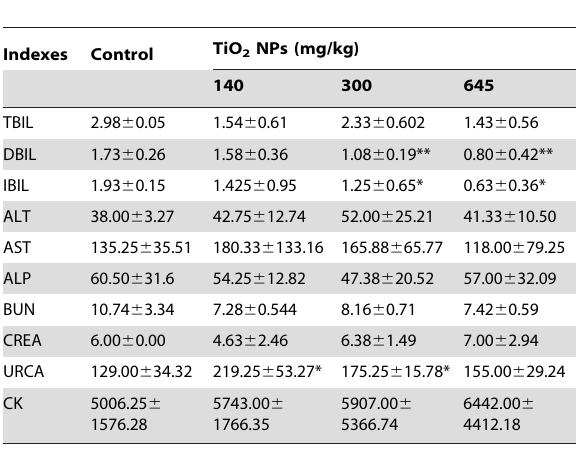
Table 3. Biochemical parameters in blood serum (Mean 6 SD).